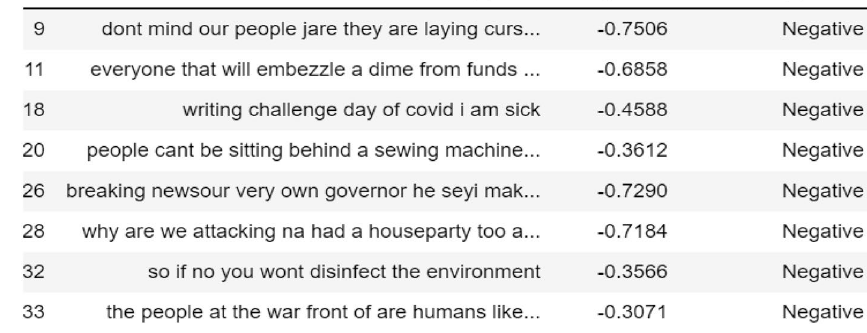
Fig. 8 List of tweets classified by VADER as negative sentiment